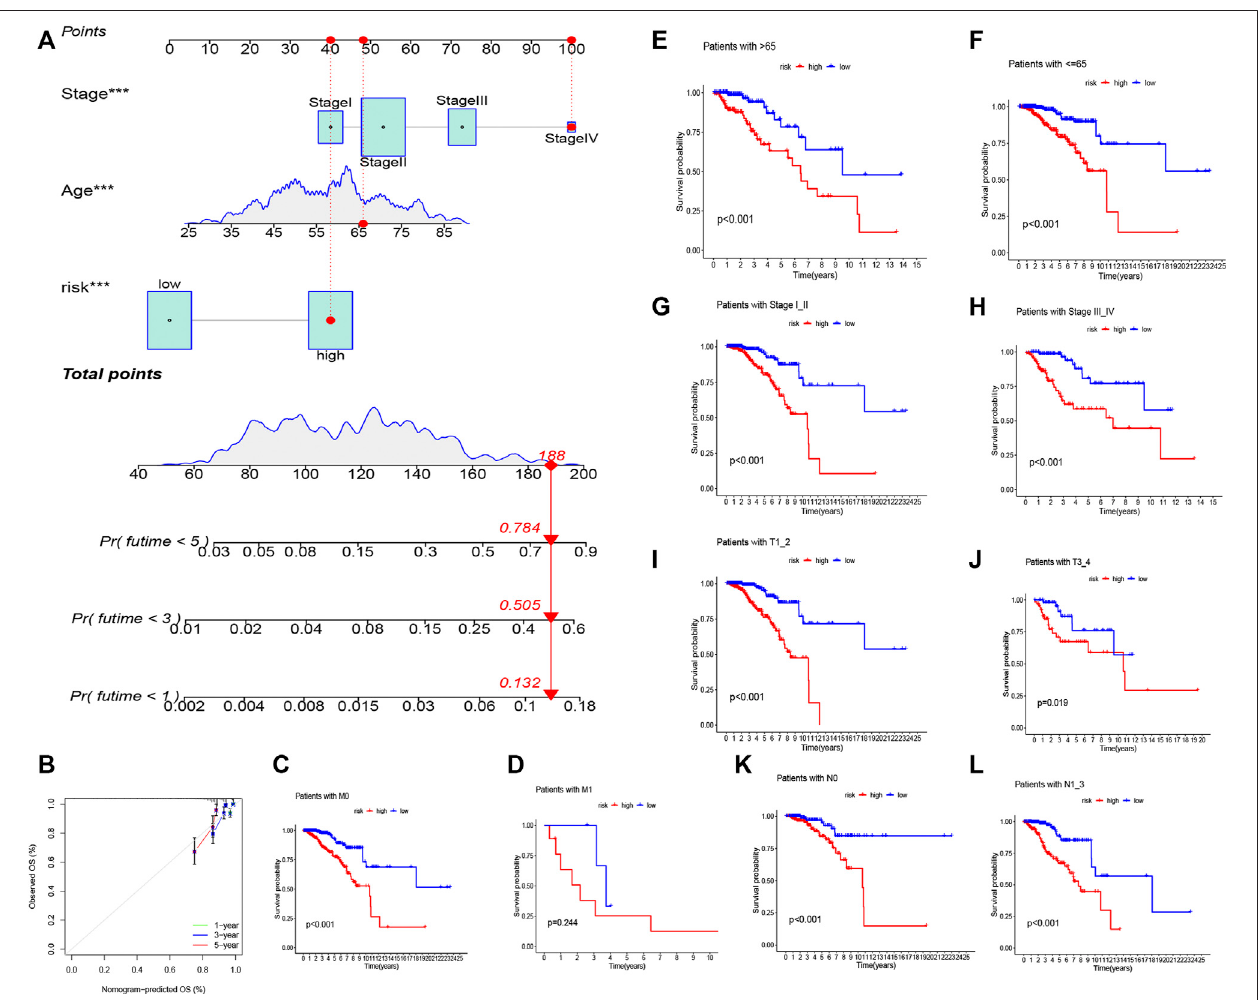
FIGURE 5 | Nomogram of both prognostic AAM-associated lncRNAs and clinical – pathological factors (A) . Calibration plot for the nomogram (B) . Strati fi cation analysisoftheriskscoreinBRCA. (C,D) Age(age > 65andage ≤ 65years). (E,F) Tumorstage(I – IIorIII – IV). (G,H) TumorTstage(T1 – 2orT3 – 4). (I,J) TumorMstage(M0 or M1). (K,L) Tumor N stage (N0 or N1 –